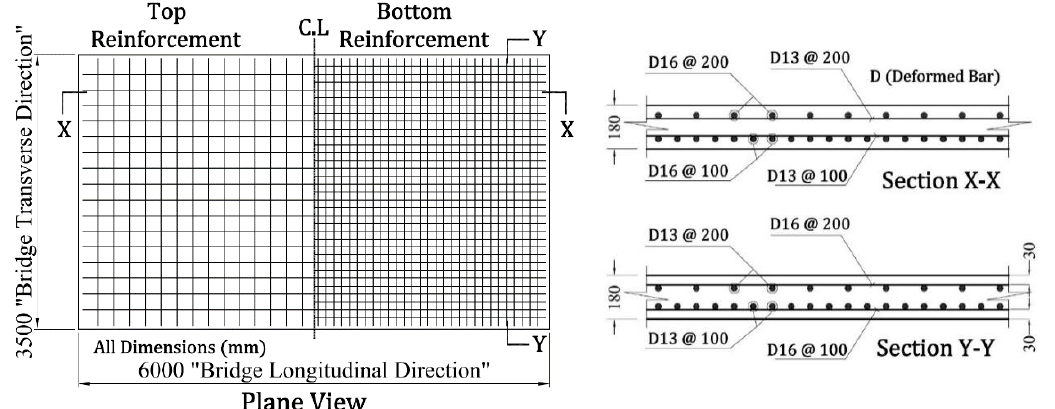
Figure 5. Dimensions and reinforcement arrangement of the studied slab.